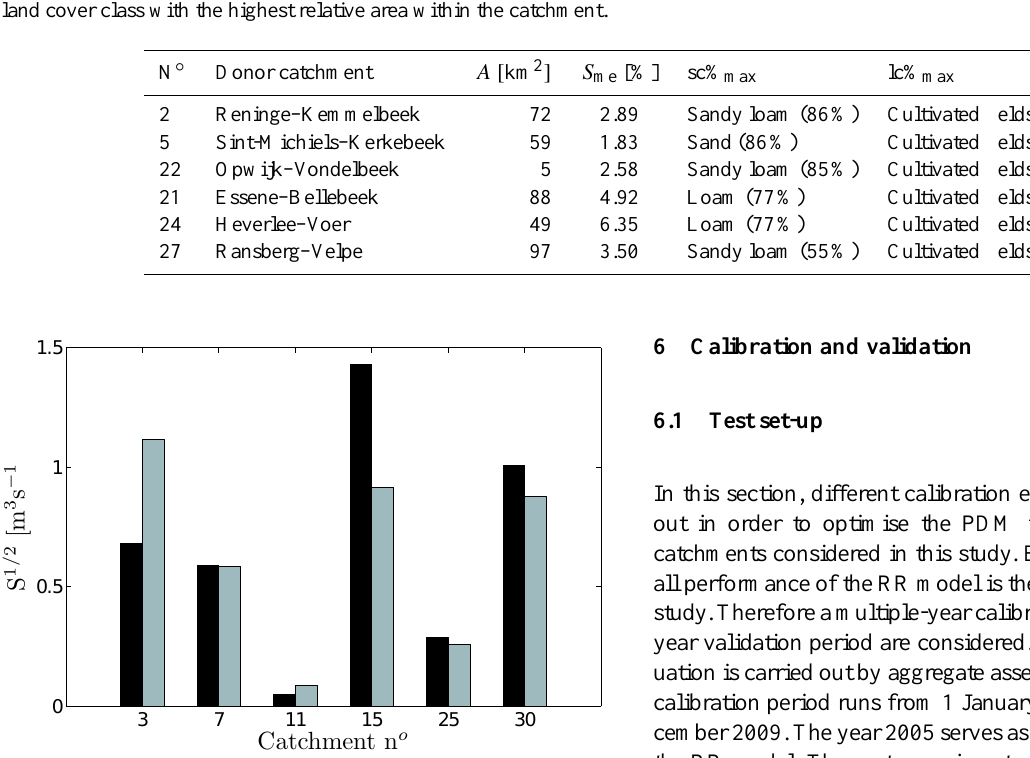
Fig. 3. Actual (black) vs. estimated (grey) root squared spectral den- sity ( k = 0) of the discharge time series for the six autochthonous catchments in the case of spatial gauging divergence (period 2006– 2009). The estimates are rescaled root squared densities of the donor discharge time